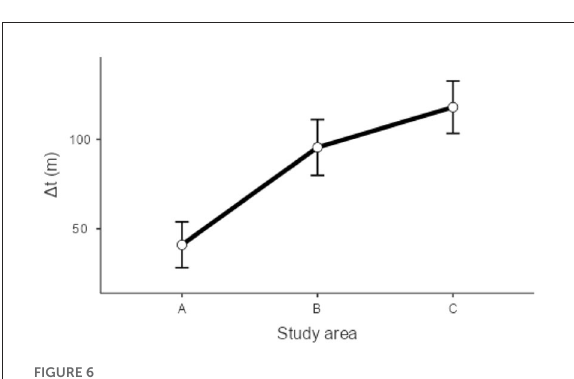
FIGURE6 Plot results for the generalized linear models regarding differences in return time between